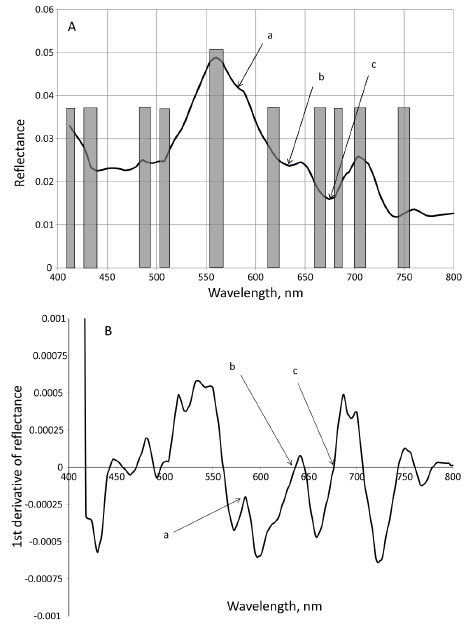
Figure 4. The detection of subtle absorption bands made possible with a hyperspectral resolution. ( A ) The median spectral reflectance of the turbid waters of the Azov Sea, Russia, is shown over the multispectral bands of MERIS; ( B ) The first derivative of the reflectance signal. The absorption bands of ( a ) phycoerythrin; ( b ) phycocyanin and ( c ) chlorophyll- a . Figure courtesy of A. A. Gitelson [23]. © IOP Publishing. Reproduced with permission. All rights